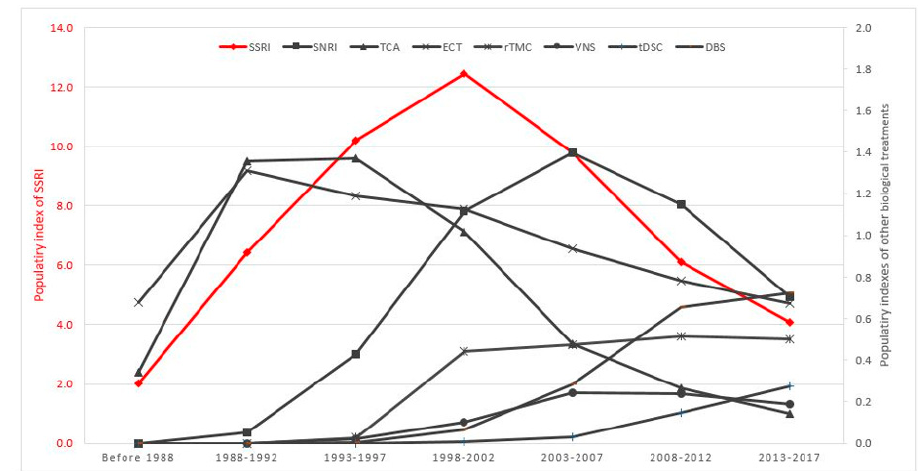
Figure 3. Time course of PI for biological treatments for MDD (1988–2017).